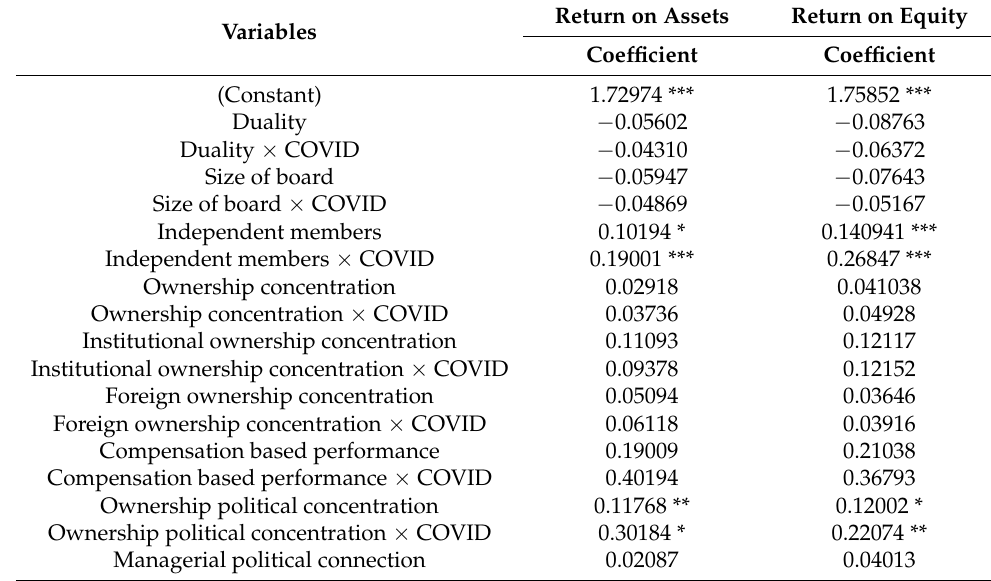
Table 9. OLS Regressions of ROA and ROE on Corporate Governance Variables and Institu- tional Variables Before the COVID-19 Crisis and During the COVID-19 Crisis including COVID as dummy